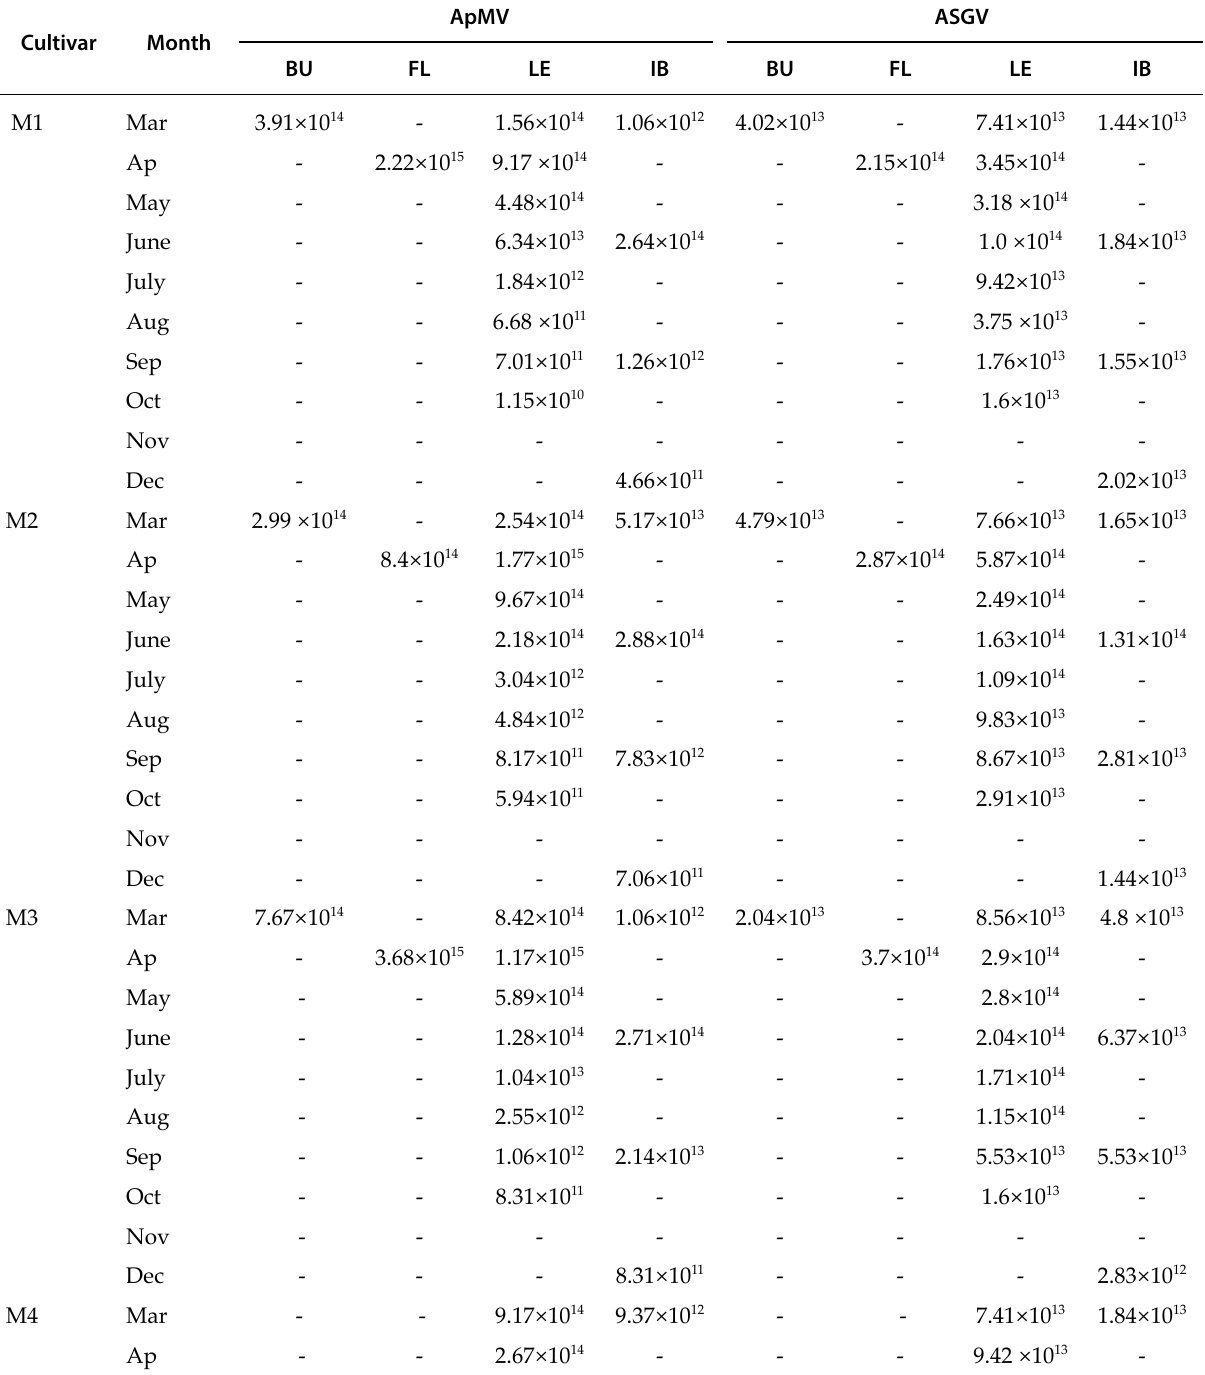
Table 2. List of absolute quantification of genomic RNA copies, obtained in RT-qPCR with an external standard curve, from different plant tissues of four apple cultivars (during ten months in 2015), that were infected with Apple mosaic virus and Apple stem grooving virus